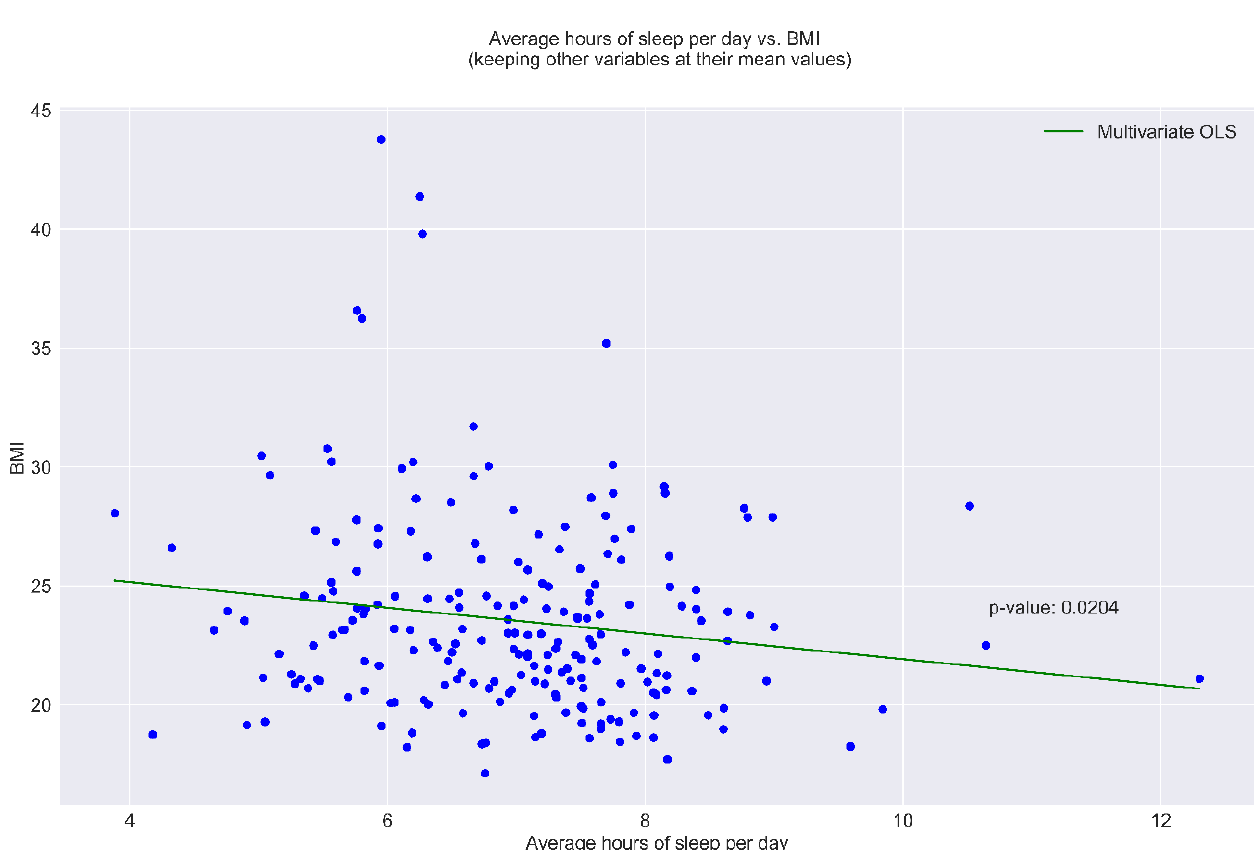
Figure 1. Relationship between body mass index (BMI) and average hours of sleep.